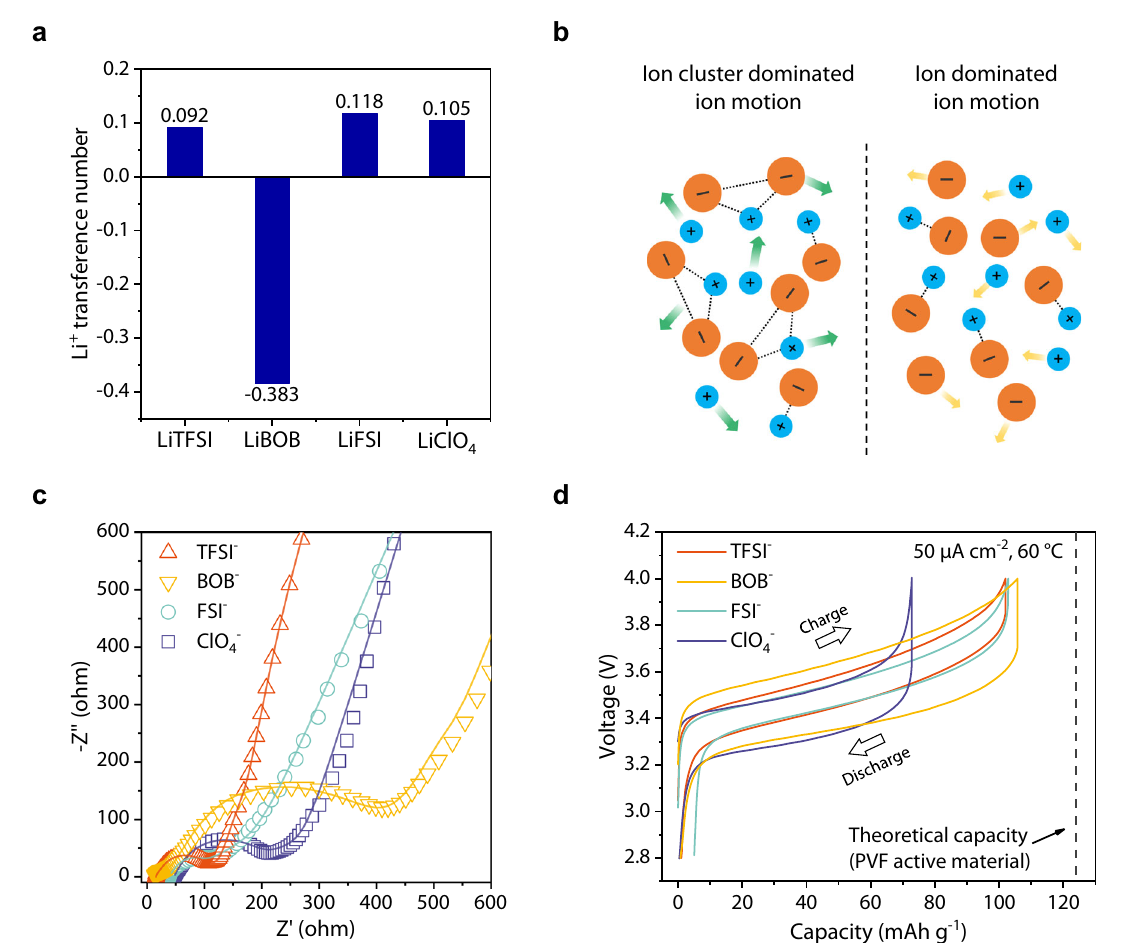
Fig. 3 Effect of the salt anion on the ion aggregation and electrochemical energy storage performance. a Lithium-ion transference number measured using steady-state current method. b Ion motion in SPEs dominated by aggregated ion cluster (left) and single ion (right). The dashed lines between ions represent short-range intracluster interactions and arrows correspond to the ion motion considered in SPEs. Considering ion cluster as noninteracting species provide an approximation more precise than the usual Nernst-Einstein equation to the t Li + , able to explain the mechanism responsible for the negative value 48, 51 . c Nyquist plots of Li||PVF cells with different anion species before cycles. The solid line represents the impendence fi tting results. d Charge-discharge curves of Li|SPE|PVF cells performed at 50 μ A cm − 2 , the theoretical capacity was marked as a dashed line. All the results were obtained at 60